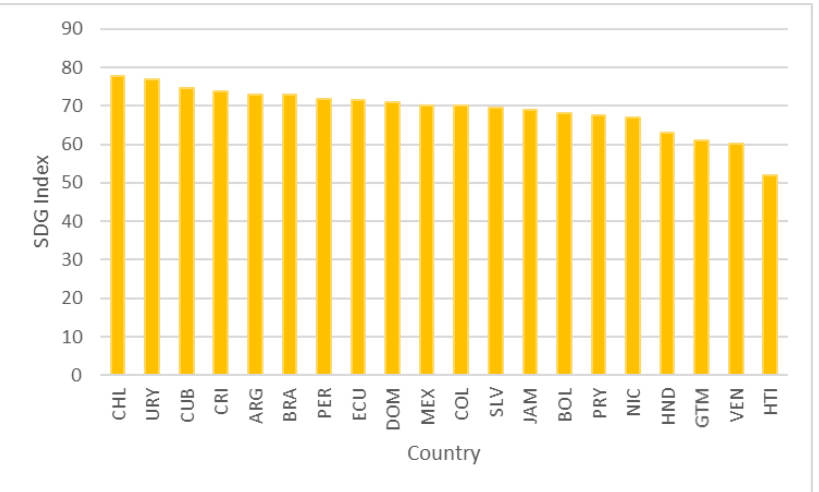
Figure 1. Global SDG Index Score (0–100) for some countries of Latin America and the Caribbean (2015–2022). Note. The difference at 100 is the distance needed in percentage to achieve the SDGs. Data are derived from indicators provided by official United Nations statistics and other non-traditional statistics, such as university centers and non-governmental organizations [36].